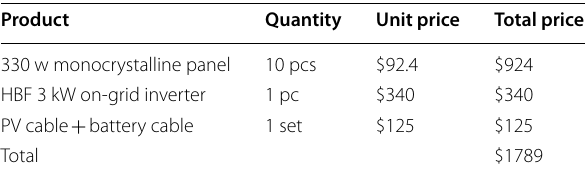
Table 2 Description of an on-grid solar power supply